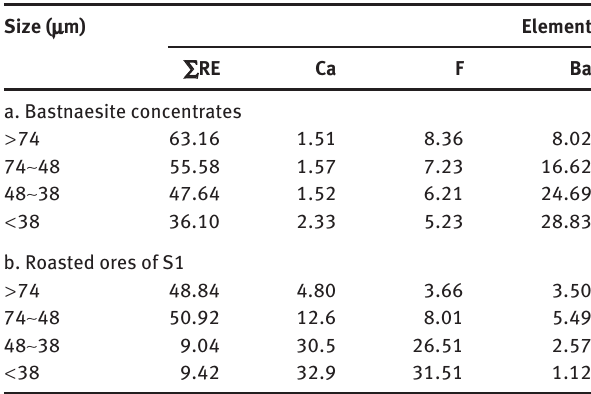
Table 4: Particles composition distribution.